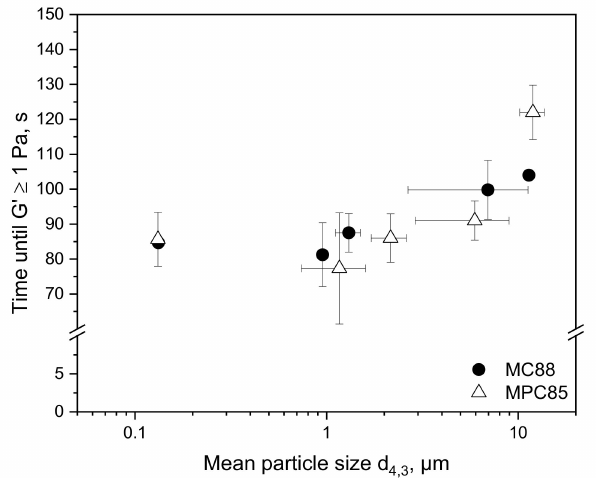
Figure 3. Time until the onset of gelation (G (cid:48) ≥ 1 Pa) of skim milk enriched with MC88 and MPC85 as a function of mean particle size d 4,3